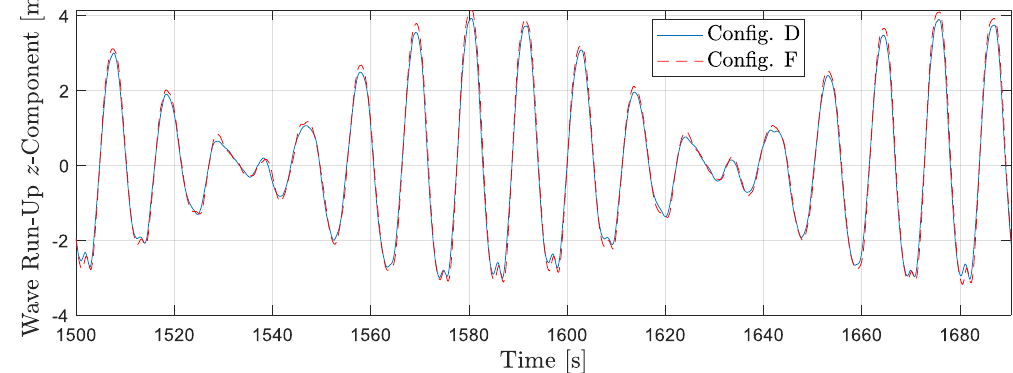
Figure 17. Comparison of full − scale wave run − up in the vertical z − direction in front of a single upper column with Heave Plate 1 in bichromatic wave B4. Configuration D has an upright column, and Configuration F has a 5° pitched column.